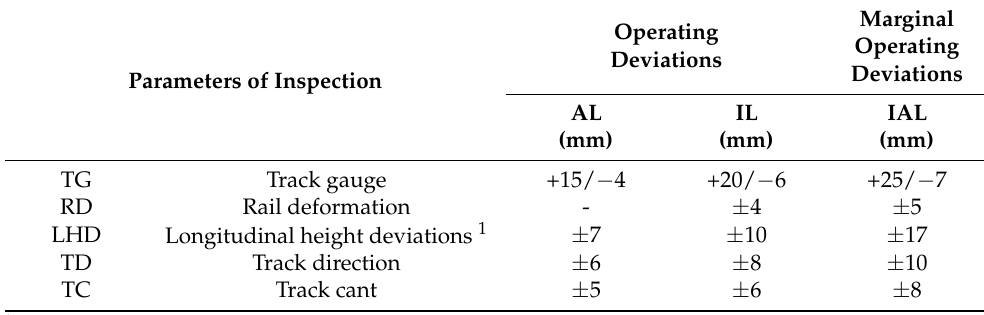
Table 2. Operating deviations AL, IL, and IAL [18] at speed of V = 160 km/h.